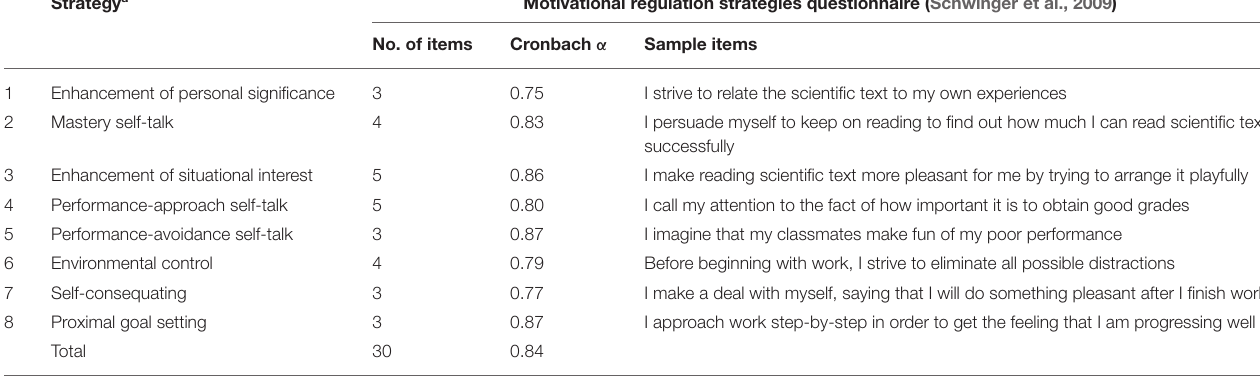
TABLE 3 | Repertoire of eight motivational management